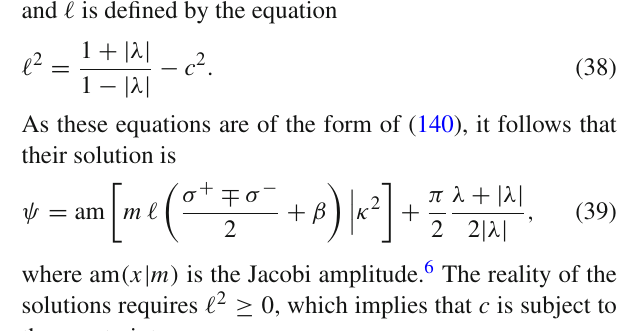
Table 3 First class of solution for the SU ( 2 )/ U ( 1 ) λ -deformed